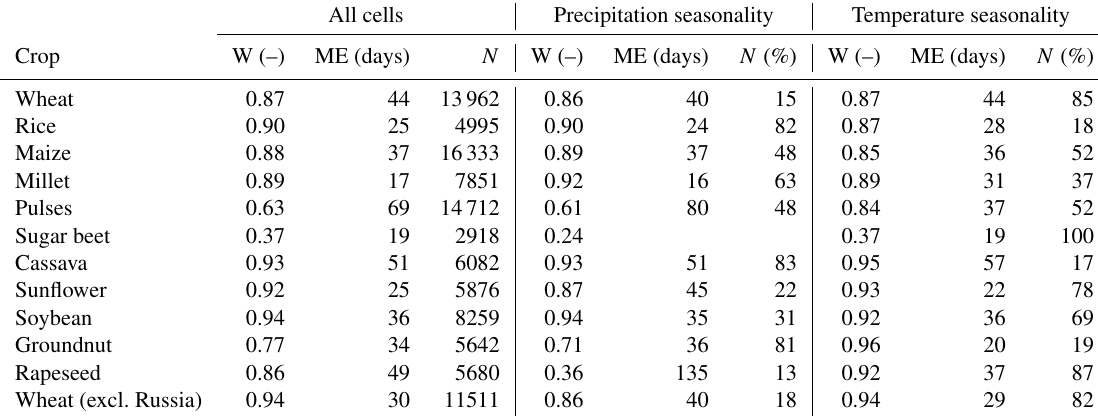
Table 5. Indices of agreement between simulated (LPJmL4) and observed (MIRCA2000) sowing dates. All cells